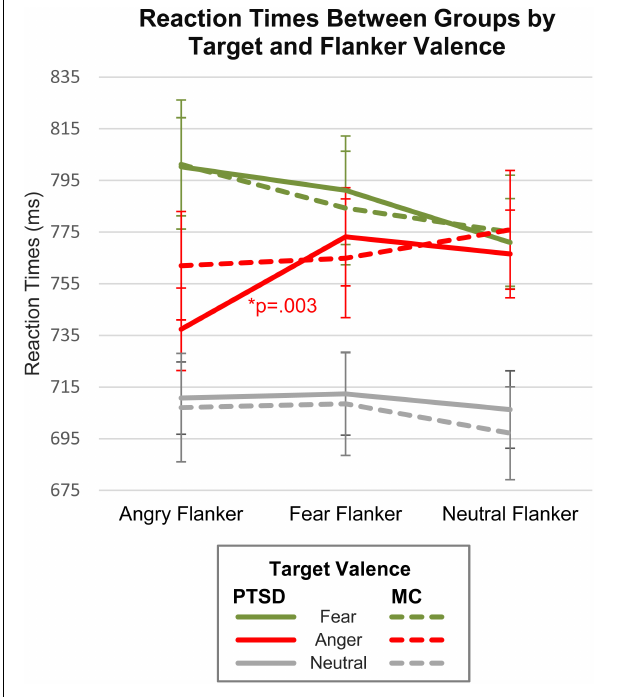
FIGURE 2 | Reaction times by valence, congruency and group. Congruent conditions include A–A, F–F, and N–N. Incongruent conditions include A–F,